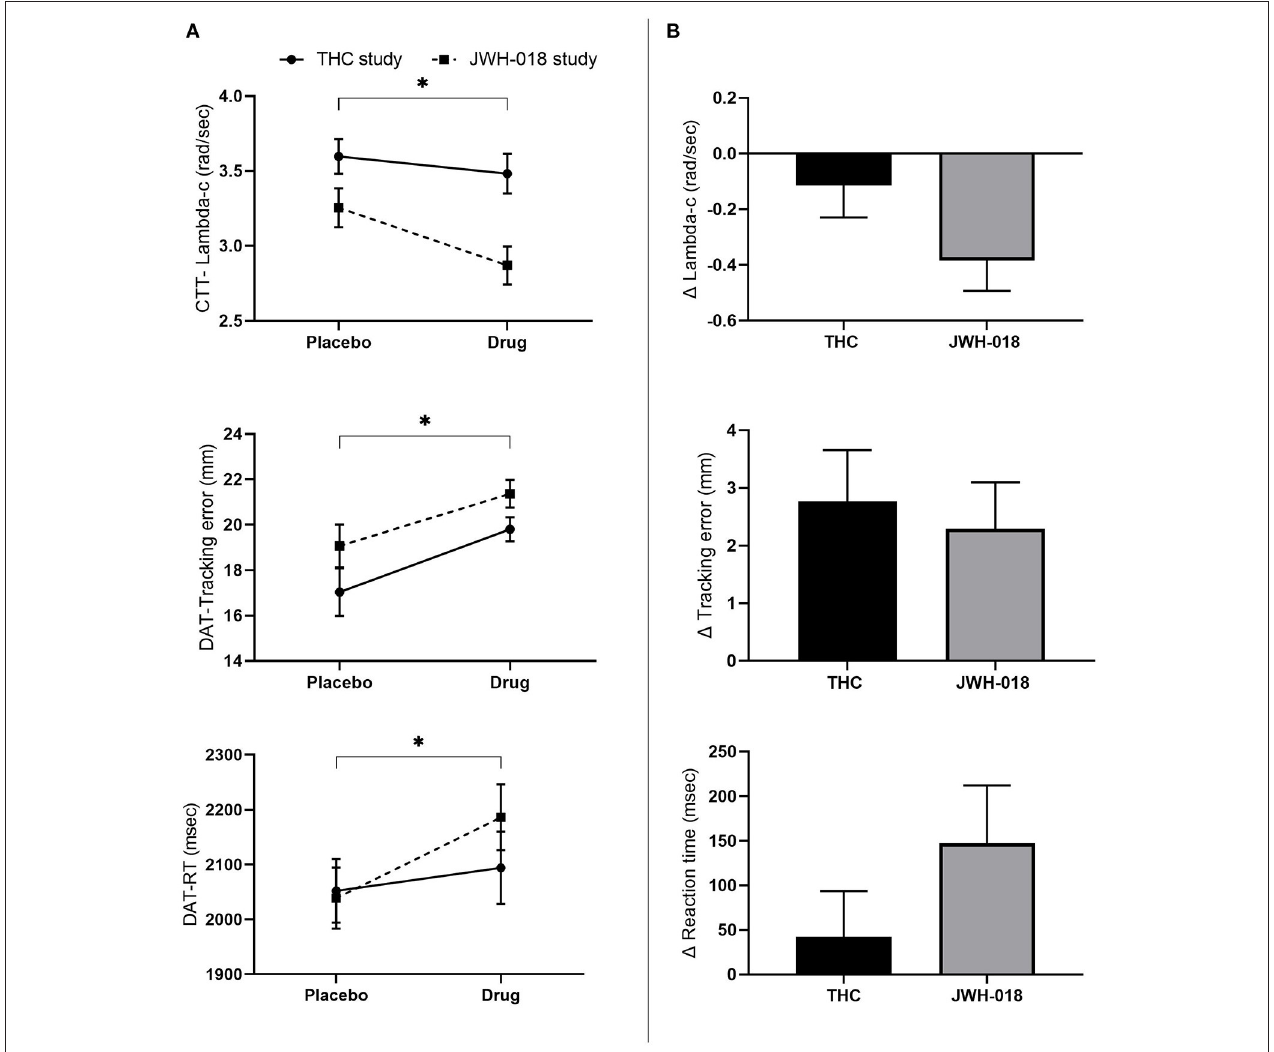
FIGURE 3 | (A) Mean (SEM) values for lambda-c in the critical tracking task, and tracking error and reaction time in the divided attention task for placebo and drug conditions, in the THC and JWH-018 study. (B) Lambda-c in the critical tracking task, and Tracking error and reaction time in the divided attention task for both drug conditions shown as difference scores (relative to placebo). *Significant difference between the active condition (THC/JWH-018) and